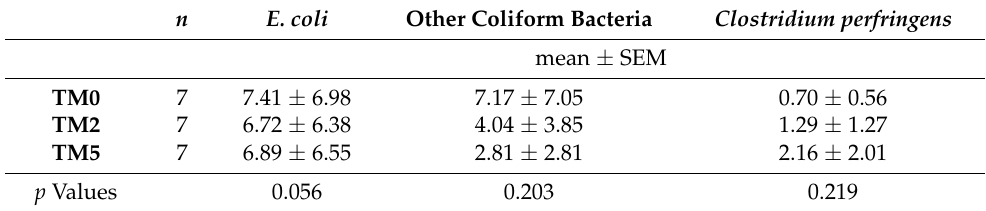
Table 4. Ceca microbiota (log CFU/g).